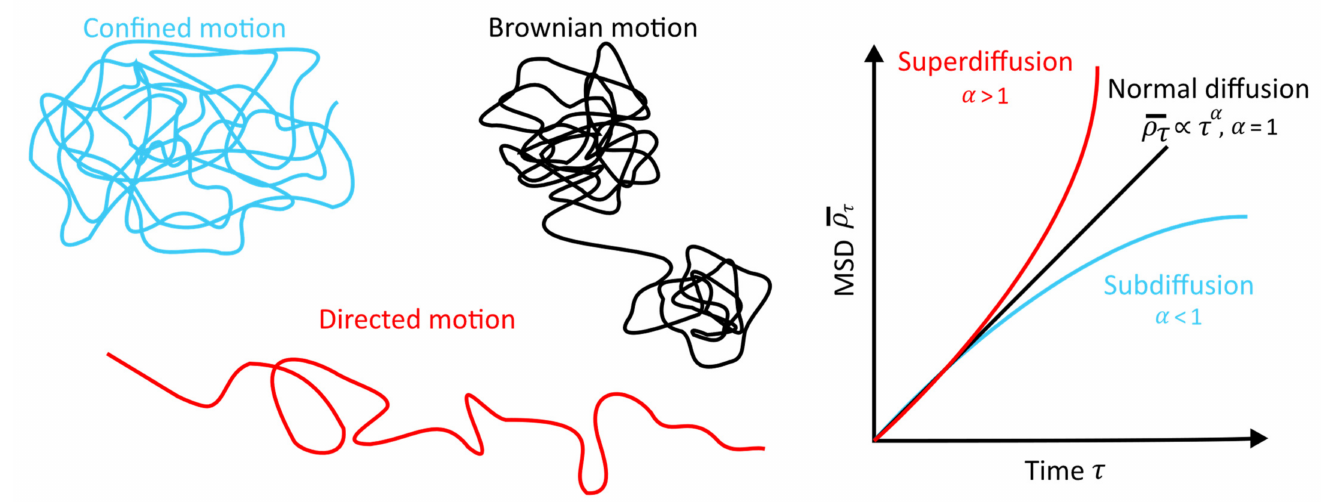
Figure 2. Different types of diffusion will result in different trajectories ( left ), leading to different MSD dependencies as a function of time ( right ). Reproduced with permission from C.H. Menq, Quantitative characterization of cell behaviors through cell cycle progression via automated cell tracking; published by PloS one,